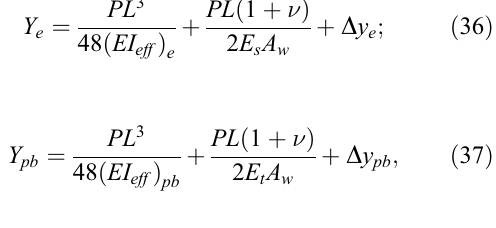
Table 1. Geometrical properties of the girders